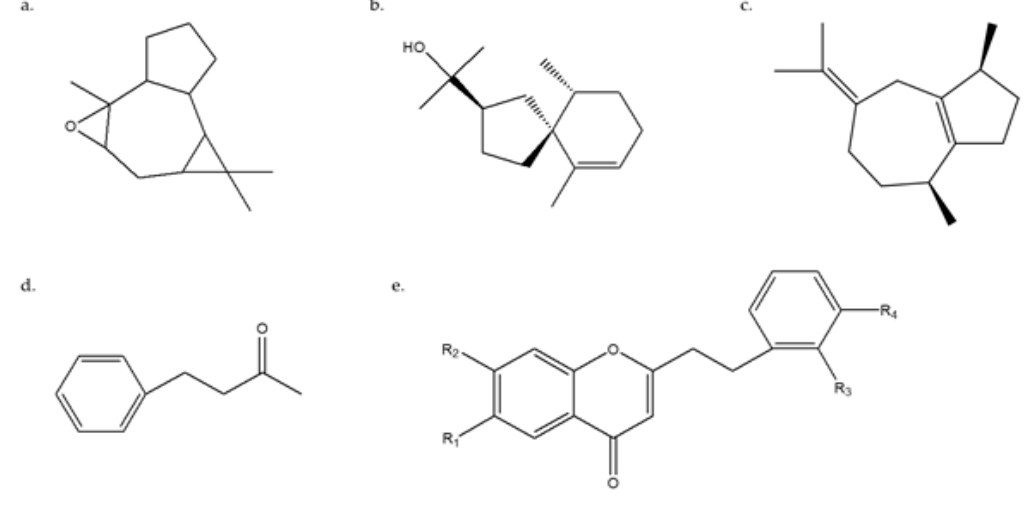
Figure 3. Structural formulas of compounds commonly found in alcohol extracts of agarwood from different regions. ( a ) isoaromadendrene epoxide, C 15 H 24 O; ( b ) agarospirol, C 15 H 26 O; ( c ) β -guaiene, C 15 H 24 ; ( d ) benxylacatone, C 10 H 12 O; ( e ) 2-(2-phenylethyl)chromone, C 17 H 14 O 2 ).